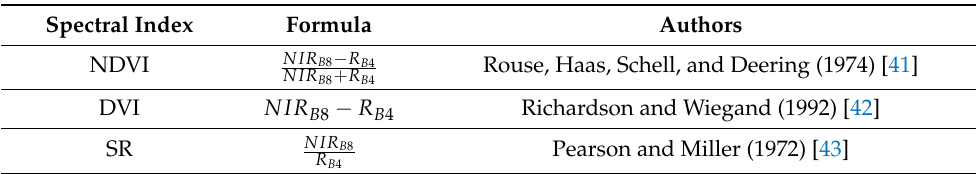
Table 2. Multispectral indices used in this